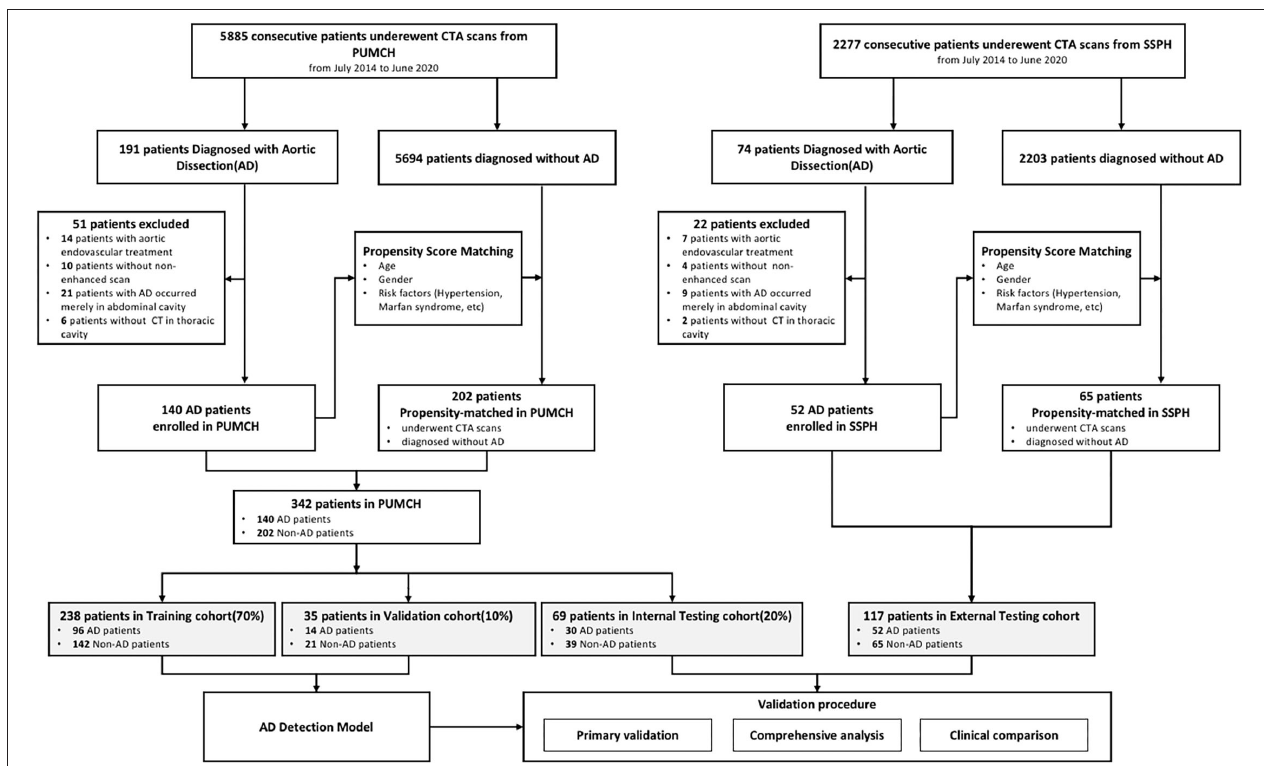
FIGURE 1 | Flowchart of enrollment of